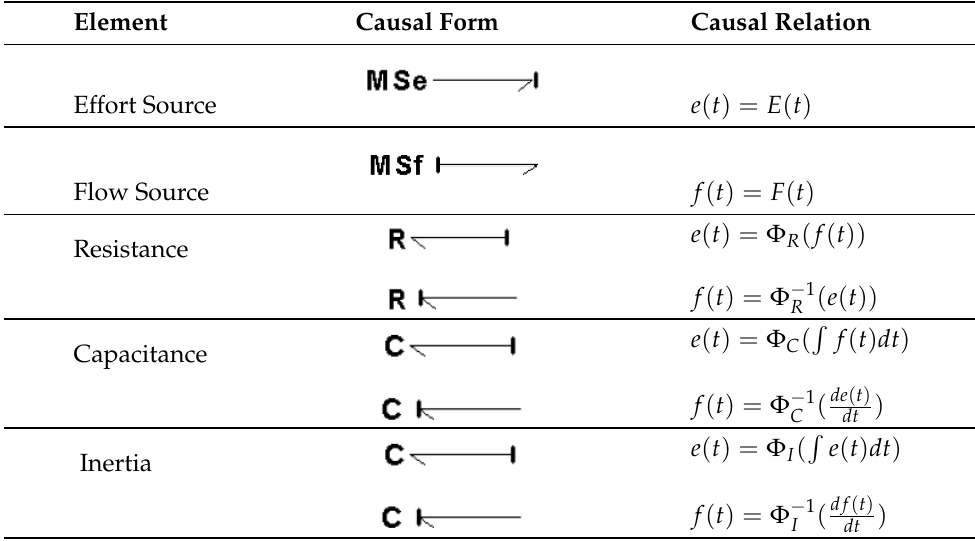
Fig. 2 . Causal bond.